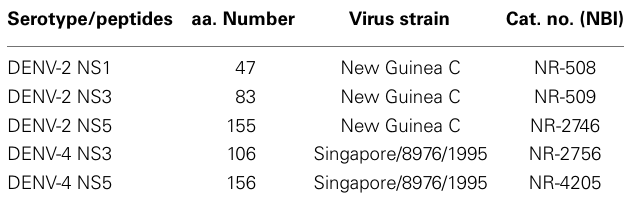
Table 2 | Peptide arrays . Serotype/peptides aa.